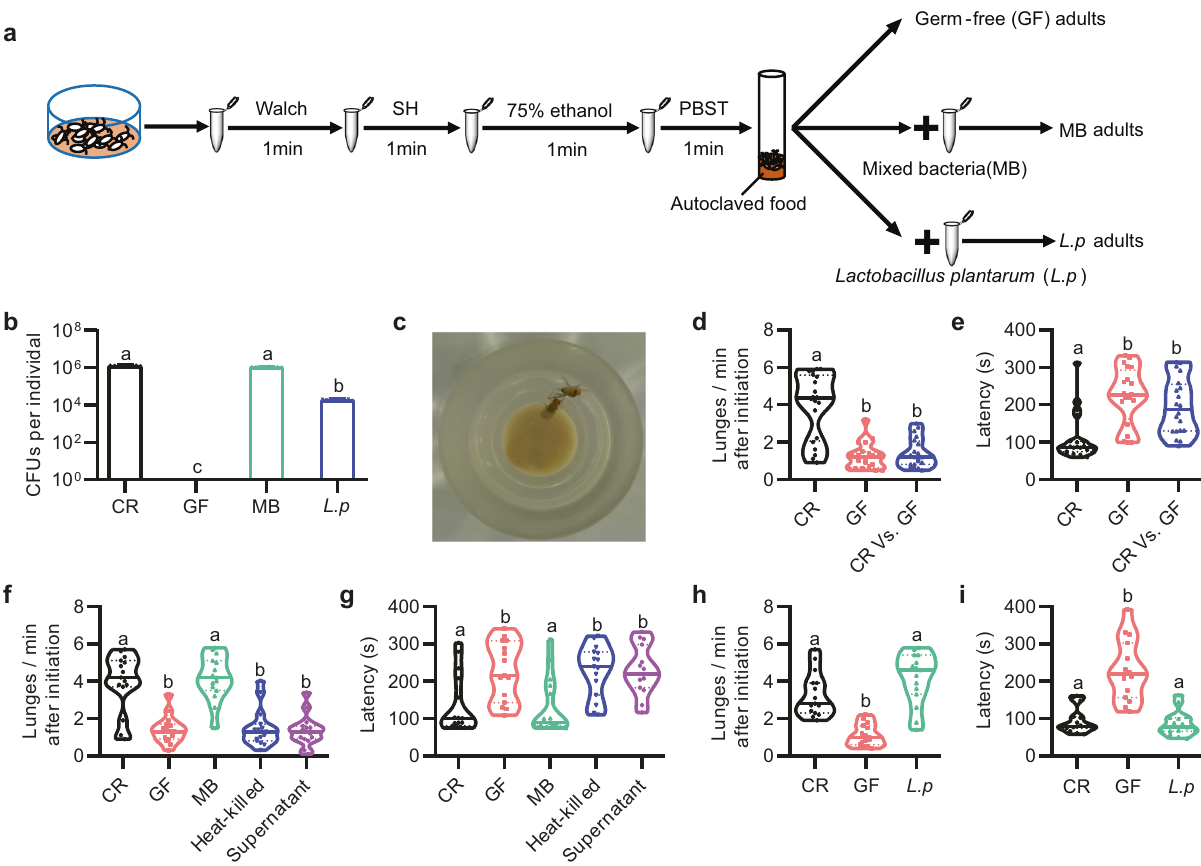
Fig. 1 Gut microbiome modulates intermale aggression. a Schematic illustration to generate germ-free (GF) and gnotobiotic fl ies. Embryos were successively sterilized with sanitizer walch, sodium hypochloride (SH), ethanol, and PBS containing 0.01% TritonX-100T (PBST). Drosophila indigenous bacteria and Lactobacillus plantarum ( L.p ) were inoculated to generate MB and L.p -associated adults. b Internal bacterial load of CR, GF, MB, and L.p adults. Bacterial load is illustrated as the colony forming units (CFU). n = 8 for each. Error bars indicate SEM. c A movie still that showed lunging behavior between two males. d , e Violin plots showing intermale lunging frequency ( d ) and latency ( e ) of CR – CR, GF – GF, and CR – GF pairs. n = 20 for each. f , g Effects of live mixed bacteria (MB), heat-killed MB, or MB supernatants on lunging frequency ( f ) and fi ghting latency ( g ) in GF males. n = 15 for each. h , i Lunging frequency ( h ) and fi ghting latency ( i ) were restored by L.p recolonization in GF males to the level of CR males. n = 15 for each. For all variables have different letters, they are signi fi cantly different ( p < 0.01). Kruskal – Wallis test followed by Dunn ’ s multiple comparisons Compared to males, Drosophila females exhibit distinct fi ghting patterns that are characterized by head butting and